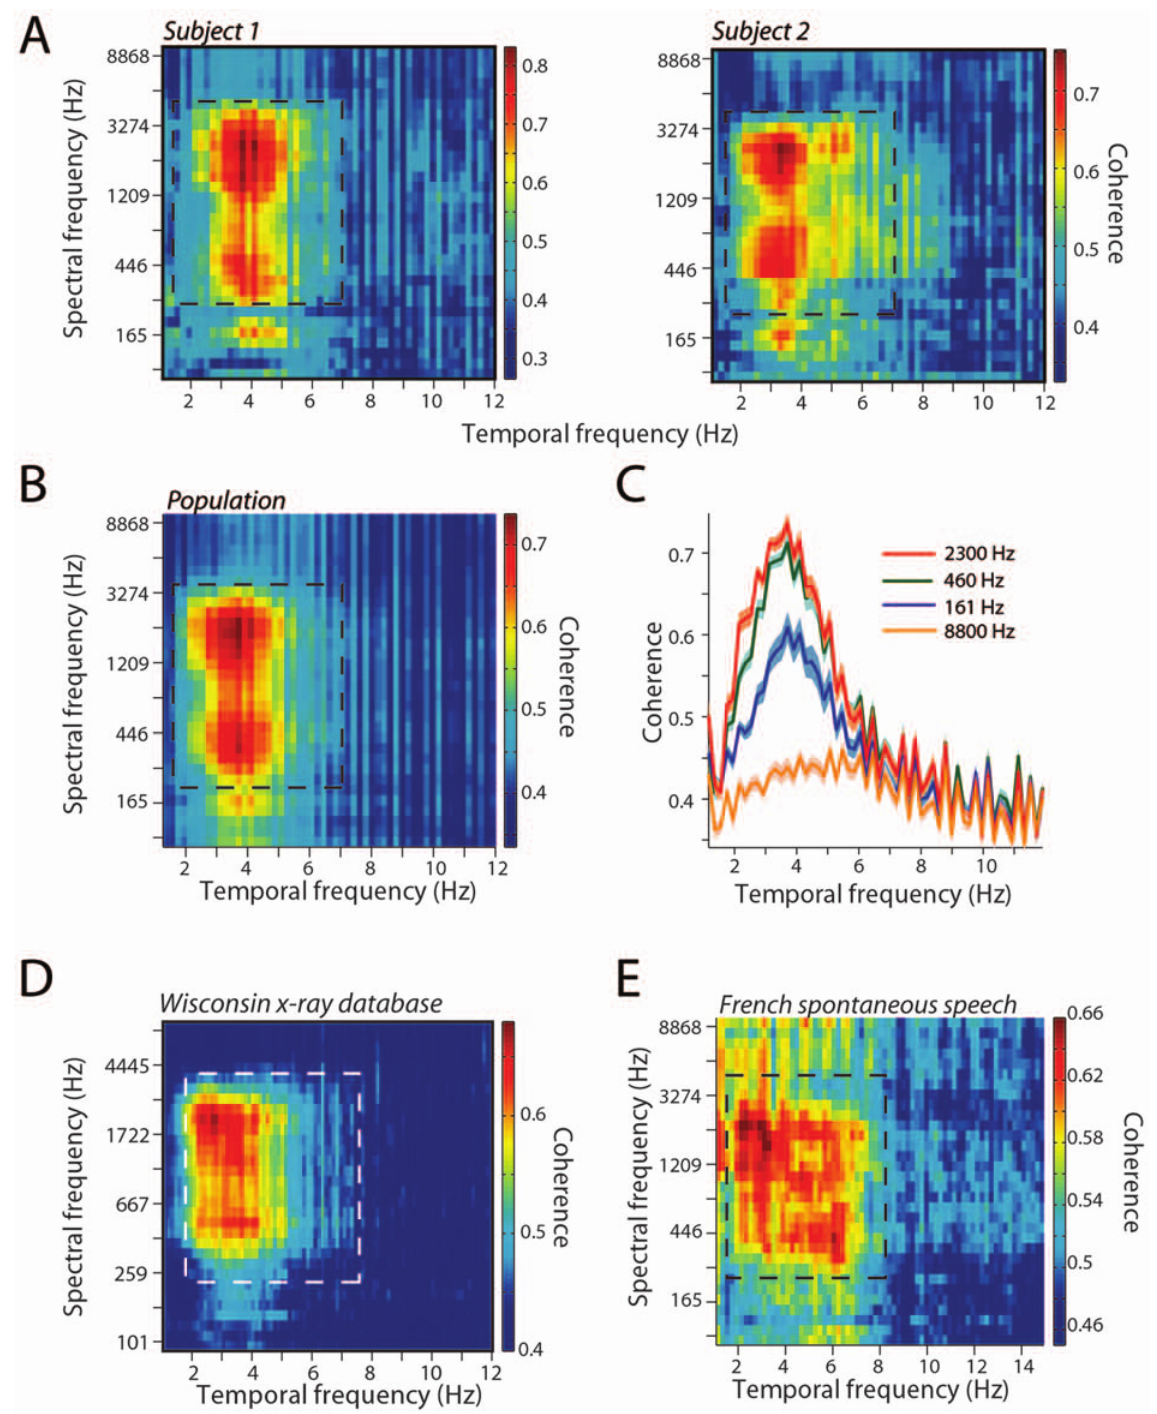
Figure 7. Coherence between vision and audition. A - Left, heat map shows the coherence between the mouth area function and the auditory signal as a function of both spectral frequency band and temporal modulation frequency for a single subject from the GRID corpus. X-axes depicts temporal modulation frequency in Hz. Y-axes depict the spectral frequency in KHz. Square drawn in dashed lines depicts the region of maximal coherence between the visual and auditory signals. Right, heat map for another subject from the GRID corpus. Figure conventions as in the left panel. B - Average coherence between the mouth area function and the auditory signal as a function of both spectral frequency band and temporal modulation frequency for the twenty subjects in the GRID corpus. Figure conventions as in the left panel of A. C - Average coherence between the mouth area function and the auditory signal for four different spectral frequencies (8.8 KHz – orange, 2.3 KHz – red, 161 Hz – blue, 460 Hz – green) across all subjects in the GRID corpus as a function of temporal frequency. Shaded regions denote the standard error of the mean. D - Average coherence between the inter-lip distance and the wideband auditory envelope as a function of both spectral frequency band and temporal modulation frequency for the fifteen subjects in the Wisconsin x-ray database. Figure conventions as in A. E - Average coherence between the area of the mouth opening and the wideband auditory envelope as a function of both spectral frequency band and temporal modulation frequency averaged across the two subjects from the French spontaneous database. Figure conventions as in A. doi:10.1371/journal.pcbi.1000436.g007 PLoS Computational Biology |